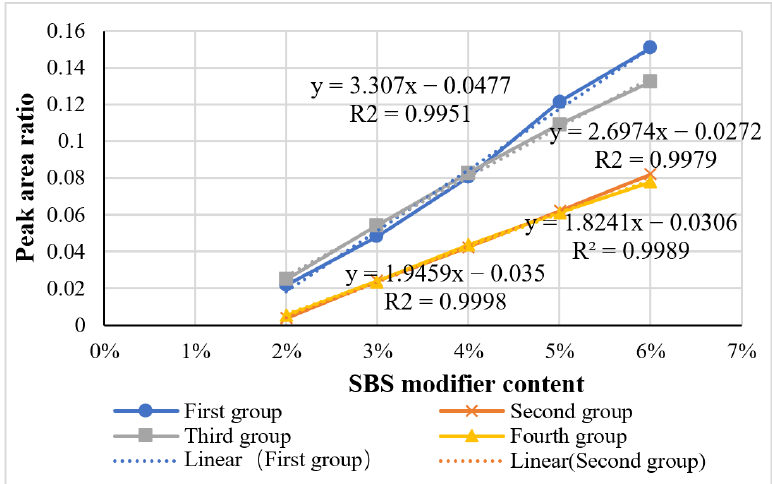
Figure 12. Standard curve of SBS content test.